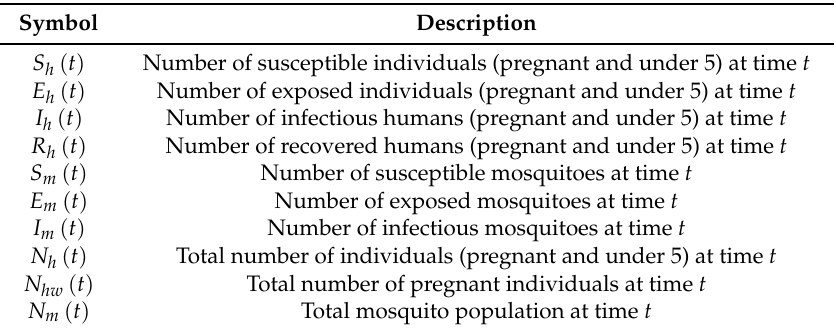
Table 1. State variables of the basic malaria model.